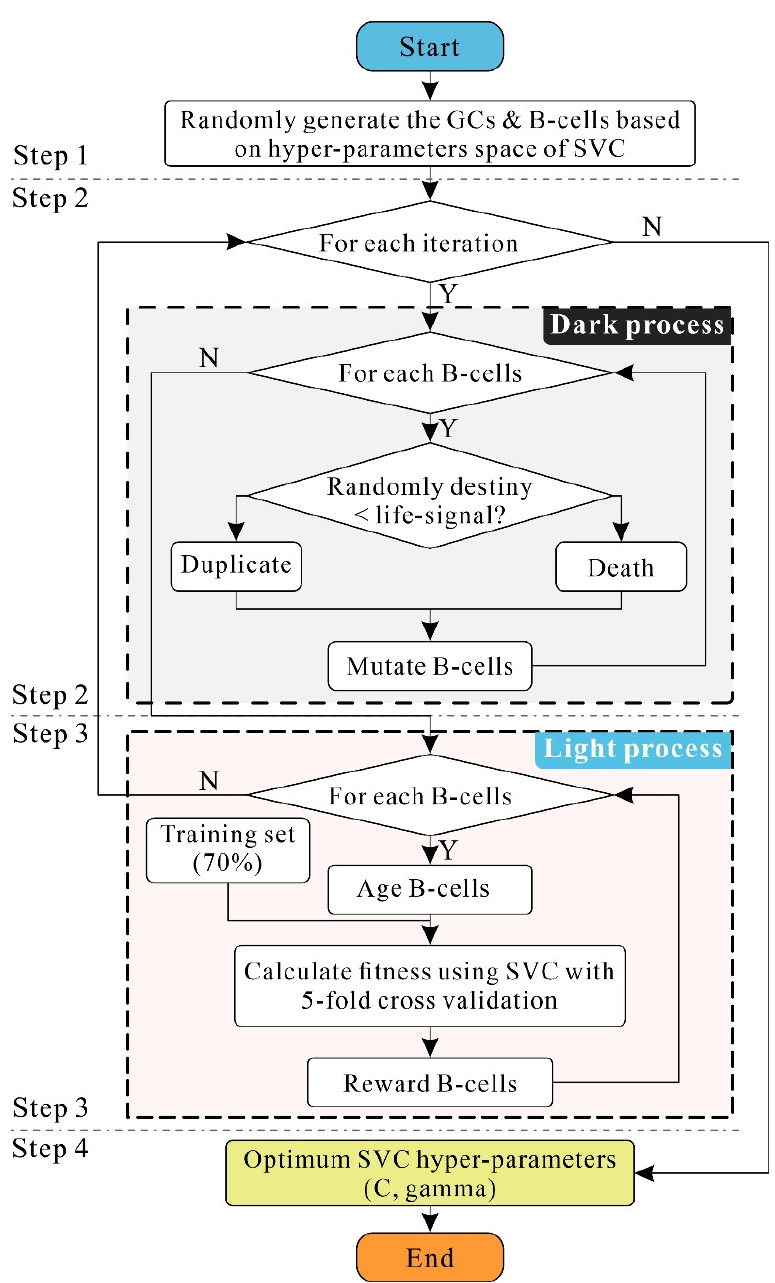
Figure 6. GCO flowchart for optimizing the hyperparameters of RBF ‐ SVC.